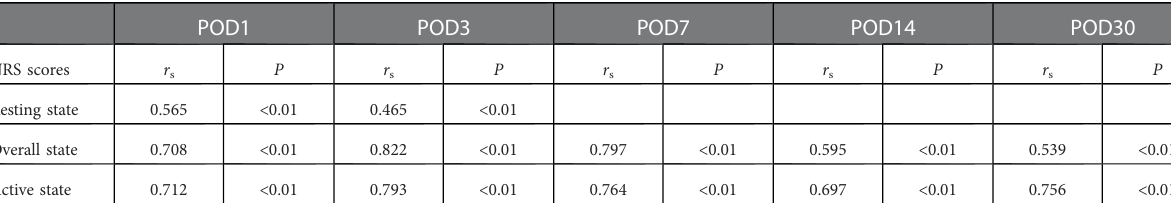
TABLE 1 Correlation of NRS and EQ-5D-5L scores after surgery. POD1